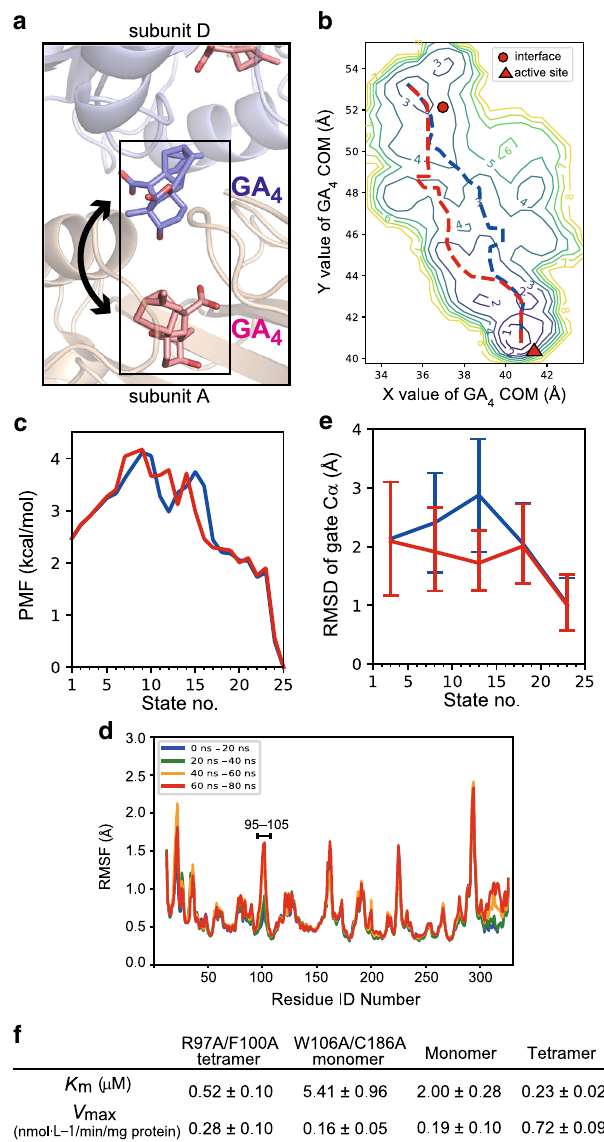
Fig. 3 Free-energy landscape of the GA 4 loading process. a Schematic view of the free-energy analysis. GA 4 was moved between two binding sites, the interface (purple) and active site (pink). b The free-energy landscape of the GA 4 loading process. Numbers represent the height of the contour in kcal/mol. The horizontal and vertical axes represent the center-of-mass (COM) coordinate of GA 4 . Two GA 4 sites found in the X- ray crystallographic analysis were plotted as a red circle and a triangle. Broken lines (magenta and orange) represent two possible pathways connecting both sites. c The relative stabilities were calculated as a potential of mean force (PMF) for the predicted two pathways in panel b . d The change in the fl uctuation of C α atoms upon the GA 4 exiting the active site. In addition to the alpha helices around K308, residues in the gate were destabilized when GA 4 exited the active site. e The root-mean- square deviation (RMSD) of the gate (near residues 96 – 106) during the simulation ( n = 8 biologically independent samples; central values and error bars represent means ± s.d.). f Kinetic analysis of monomer, dimer and tetramer of WT and mutant OsGA2ox3 ( n = 3 biologically independent